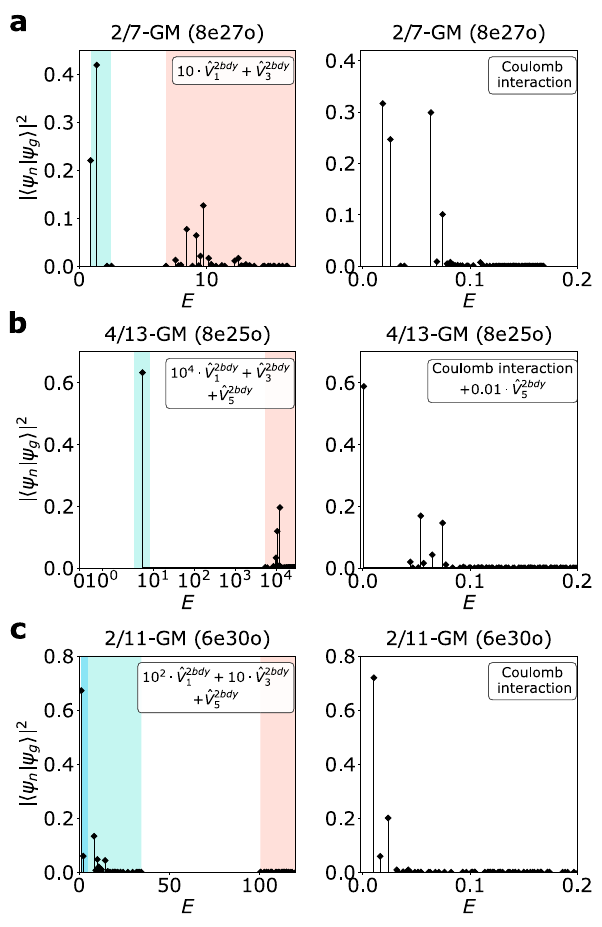
Fig. 3| Spectralfunctionsfromexact diagonalization. a – c Graviton peaksofthe FQHstateswiththe fi llingfactor ν =2/7,4/13and2/11.TheGMoftheFQHstatewith fi lling factor ν is called ν -GM for simplicity, followed by the system size, i.e., N electrons and N o orbitals denoted by N e e N o o. The blue, the turquoise, and the red region denote H 2bdy 3 , H 2bdy 1 and the complement of H 2bdy